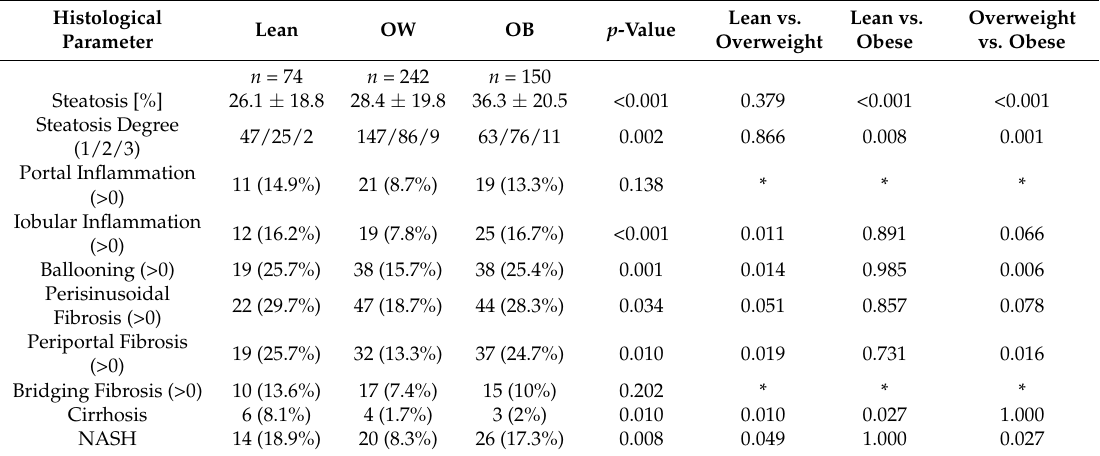
Table 3. Summary of the histological characteristics of the study